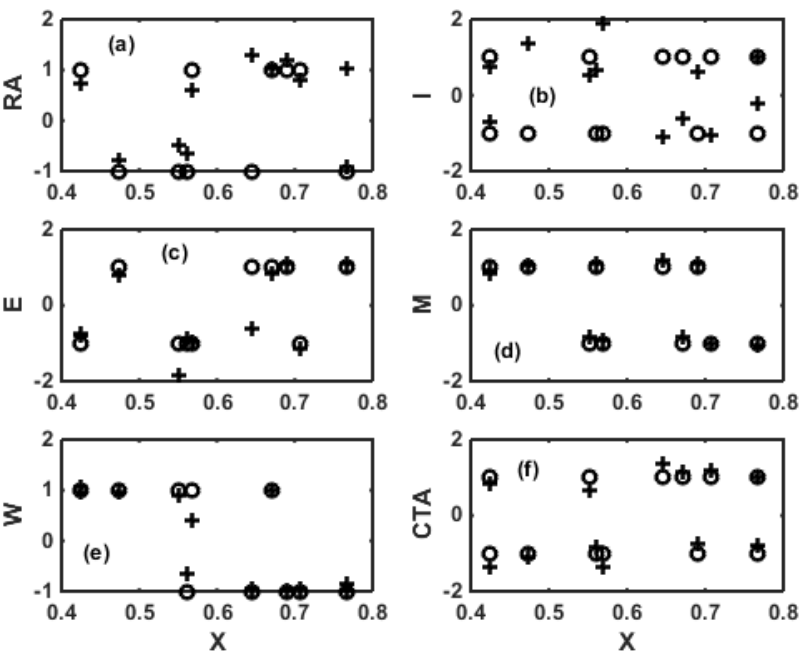
Figure 3. Comparison of the predictions between the unseen targeted values (o) and the values obtained using ANN (+) for desired conversion levels vs. ( a ) reducing agent; ( b ) initiator; ( c ) emulsifier; ( d ) monomer; ( e ) water; and ( f ) chain transfer agent.